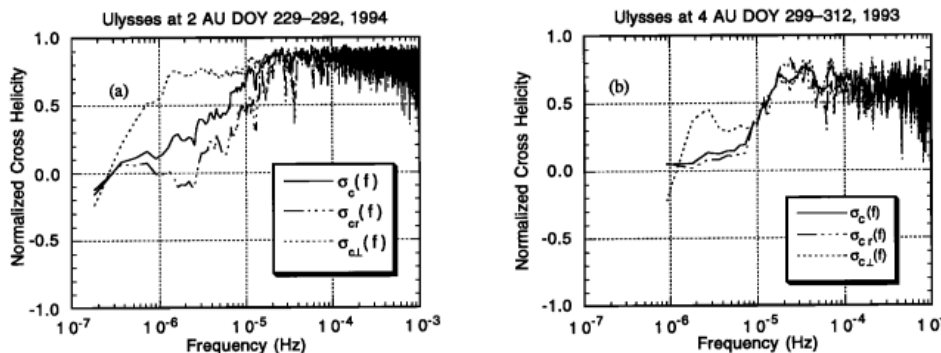
Figure 3. Reproduction of a figure (Figure 2) of the article by Goldstein et al. (1995) [13]: the normalized cross-helicity σ c as a function of frequency, at heliocentric distance r = 2 AU ( panel a ) and r = 4 AU ( panel b ). Courtesy of John Wiley and Sons. Permission to reprint